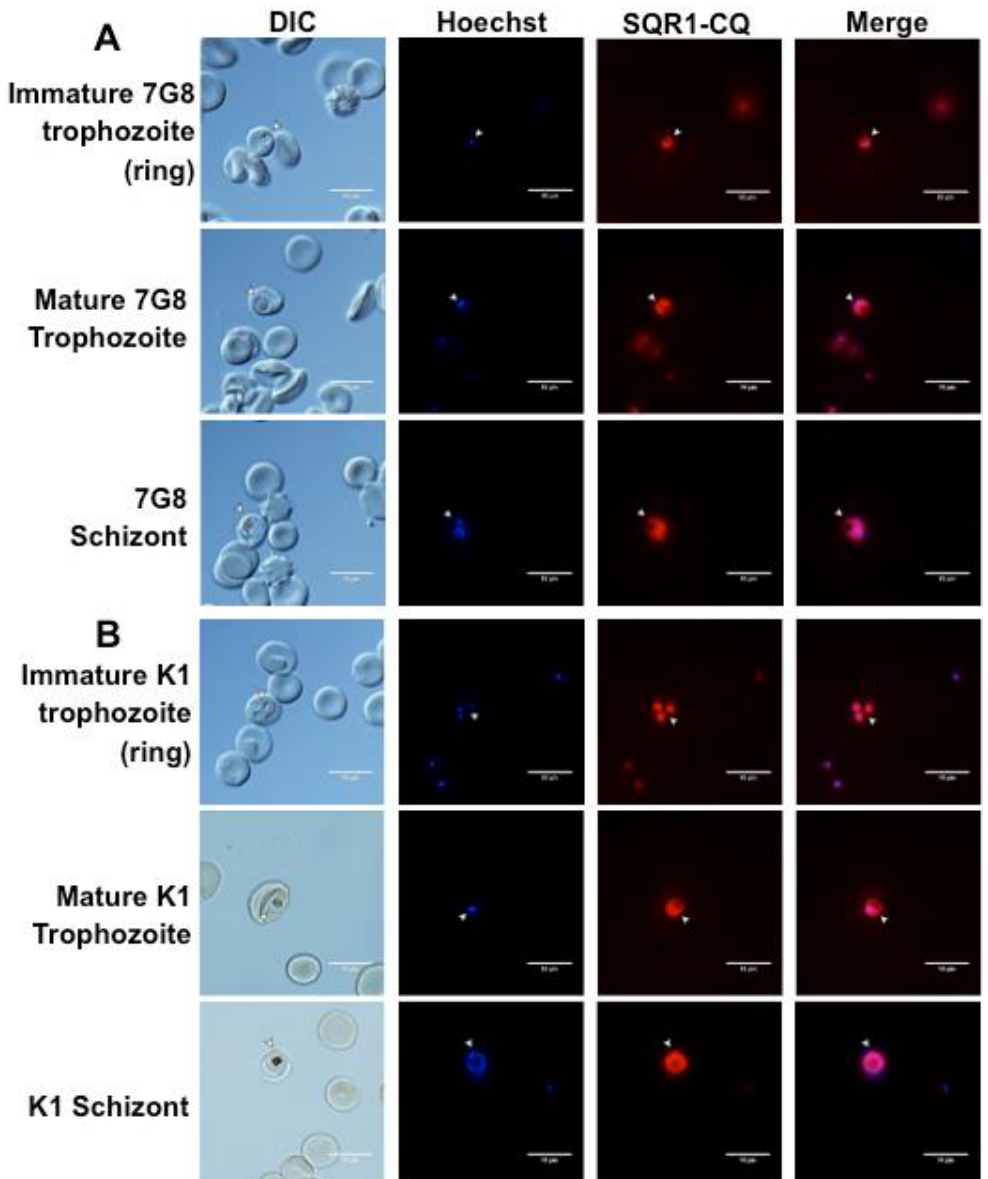
Figure 2. SQR1-CQ labelling of CQ-resistant P. falciparum . Mixed in vitro cultures of ( A ) 7G8 and ( B ) K1 P. falciparum were co-labelled with nuclear stain Hoechst 33342 and SQR1-CQ, before analyzing via confocal microscopy. Similar to 3D7, multiple stages of both intermediate and high resistance strains (arrowheads) exhibiting uptake and labelling with both dyes. Localization of SQR1-CQ in 7G8 and K1 does not differ from that observed in 3D7. Bar = 10 µ